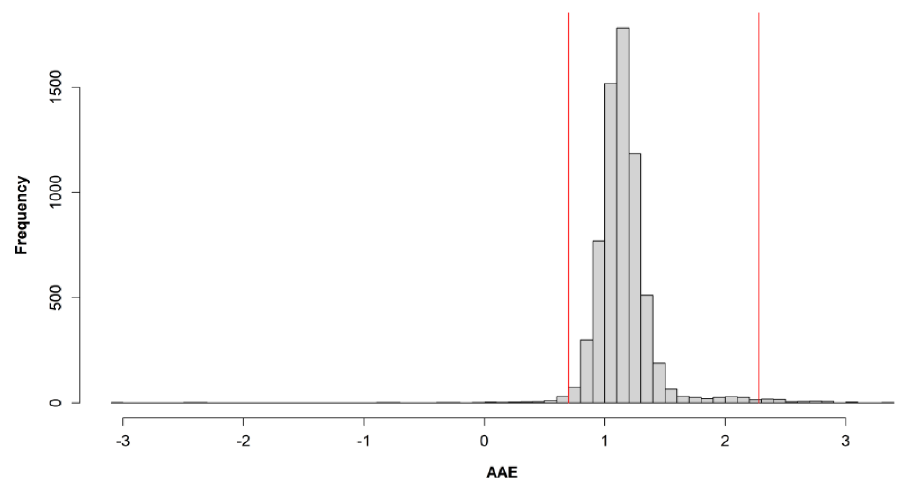
Figure A1. Histogram of AAE values computed using Equation (1).